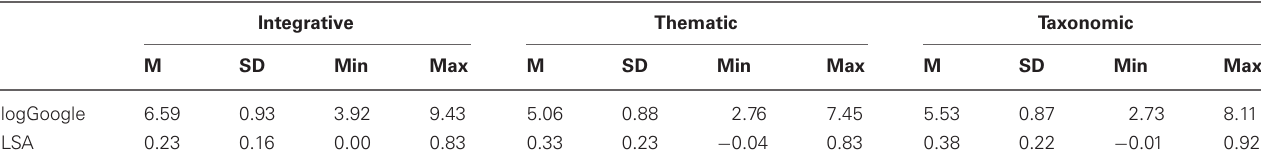
Table 1 | Study 1, Means, Standard Deviations, Minimums, and Maximums of measures and ELP control variables.